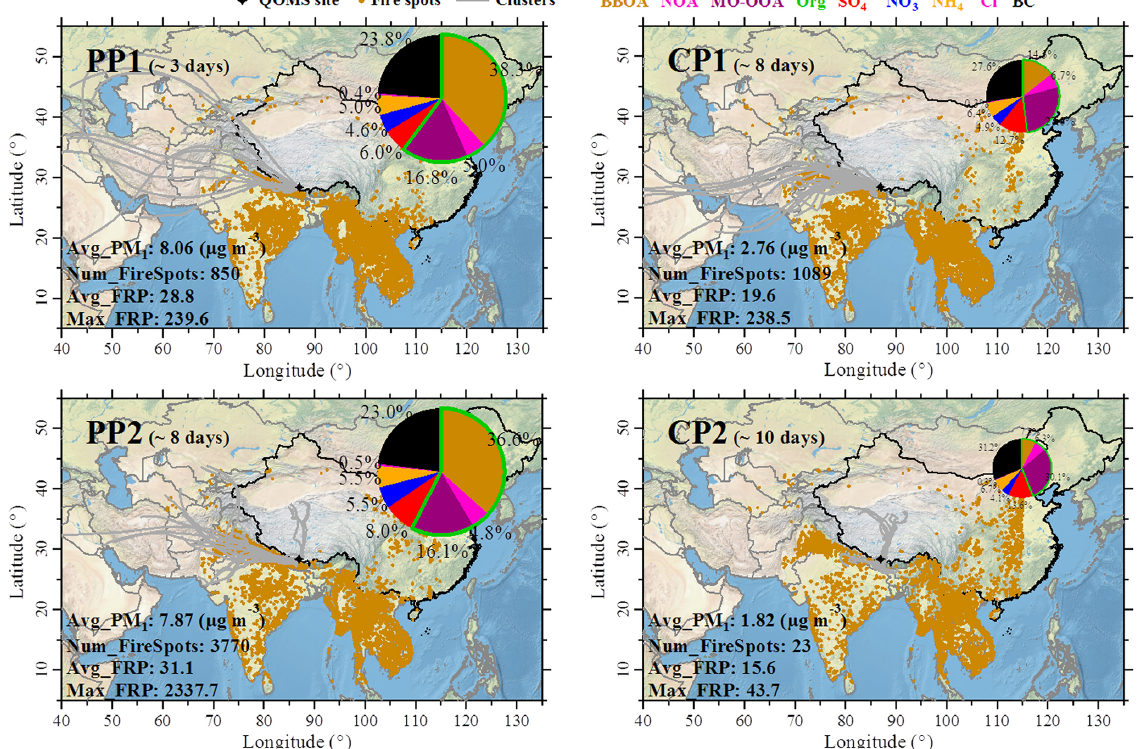
Figure 11. The 72h back trajectories (grey solid lines) calculated every 6h for the different episodes. Pie charts show the average mass contributions of PM 1 species and OA factors to the total PM 1 mass for each of the episodes (scaled by the corresponding average PM 1 mass concentrations). The average PM 1 mass concentrations, number of fire hotspots as well as the average and maximum fire radiative powers (FRP) belonging to all trajectories for the different episodes are also